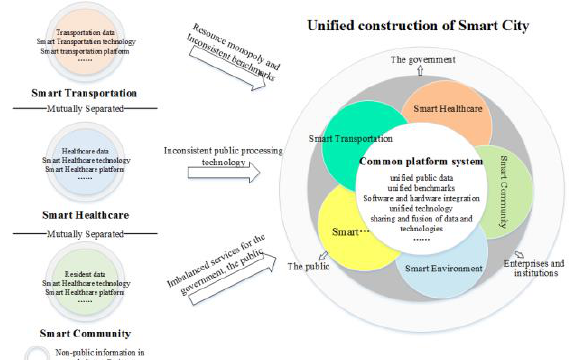
Figure 1. Schematic diagram of existing problems and strategies for smart cities